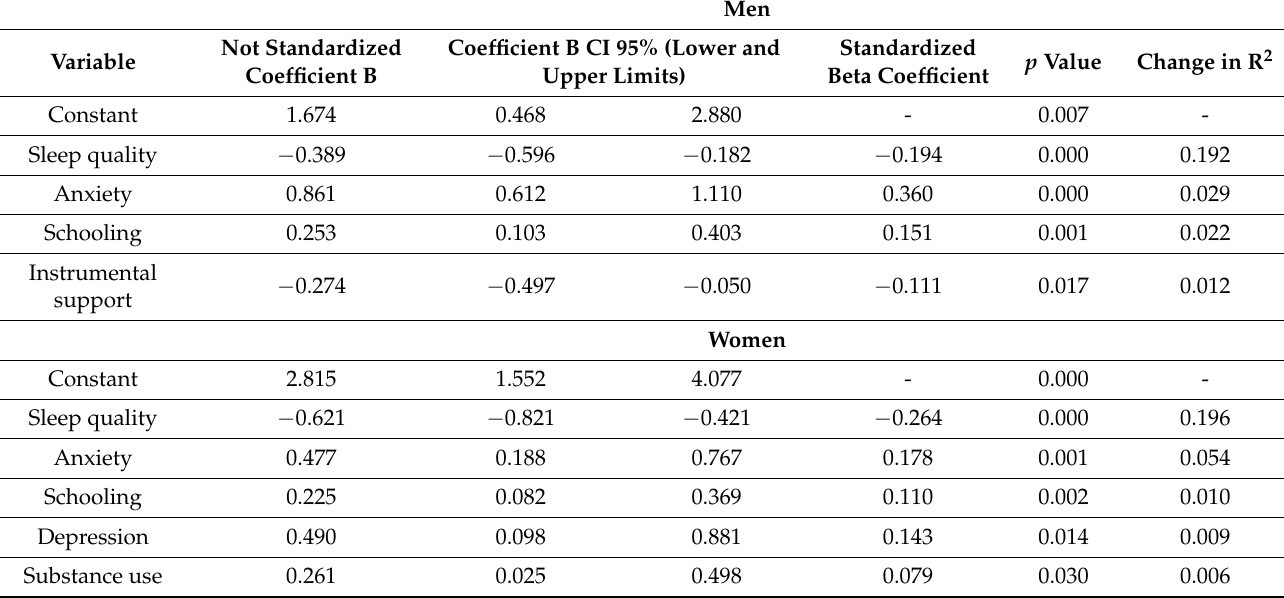
Table 6. Multivariate regression analysis for number of